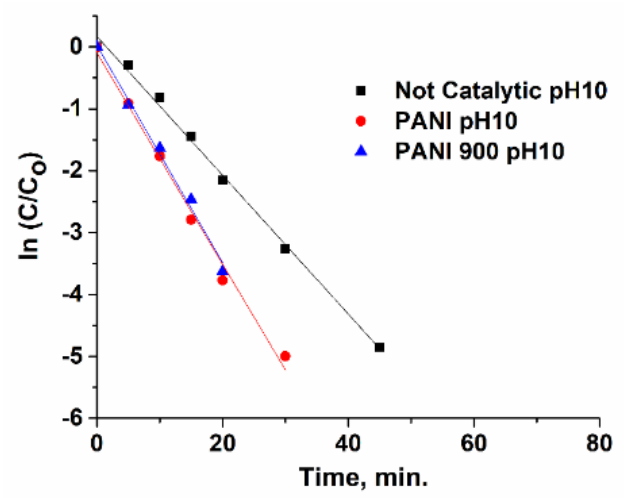
Figure 20. Pseudo – first – order plots of ln(C/C o ) with reaction time for pH 10.